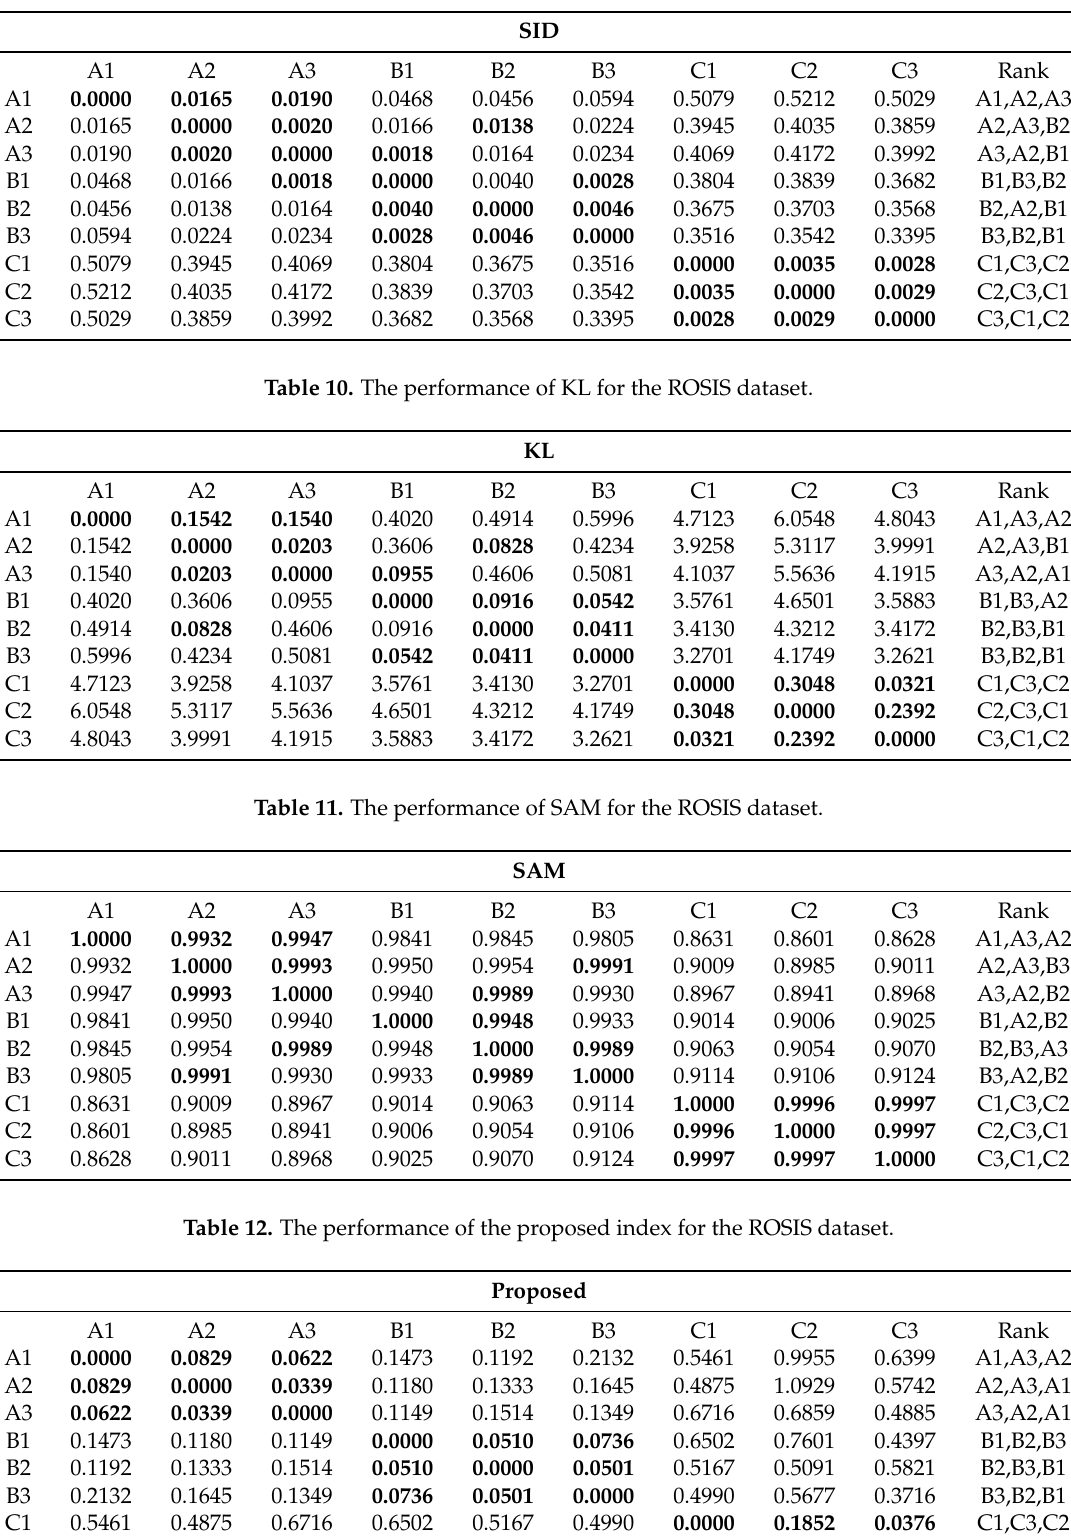
Table 9. The performance of SID for the ROSIS dataset.